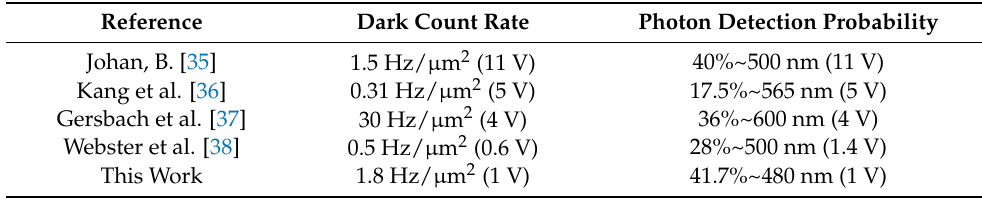
Figure 10. Measured DCR of HDEPD device (temperature: 20 °C). Table 1. Comparison of our work to HDEPD device and reference devices .